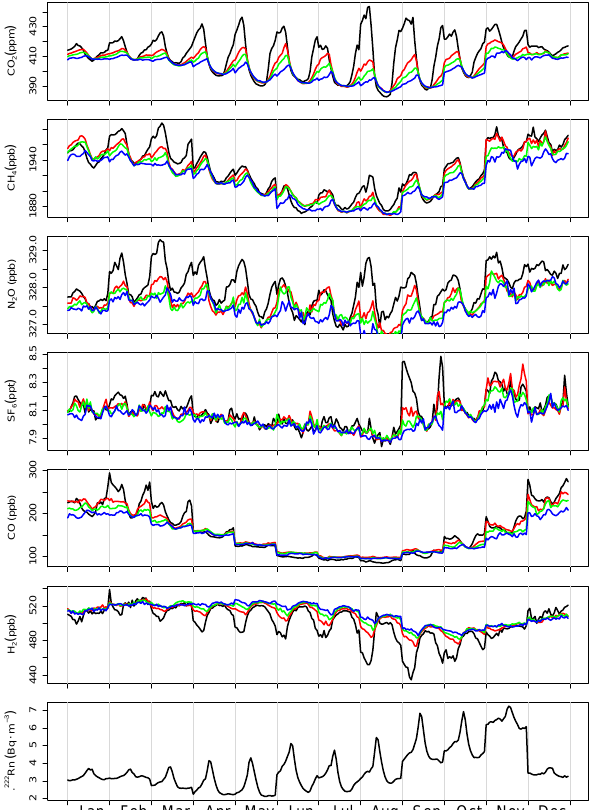
Figure 7. Mean diurnal cycles of CO 2 , CH 4 , N 2 O, SF 6 , CO, H 2 and 222 Rn for the sampling levels 5m (black), 50m (red) 100m (green) and 180m (blue).